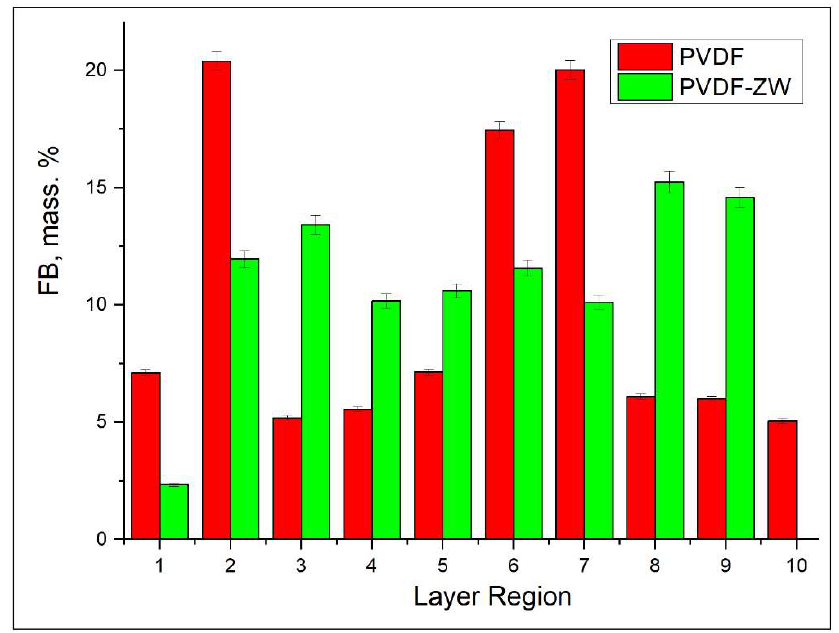
Figure 10. Comparison of FB distribution across membrane (PVDF and PVDF-ZW) thicknesses when adsorbed from a single-protein solution.